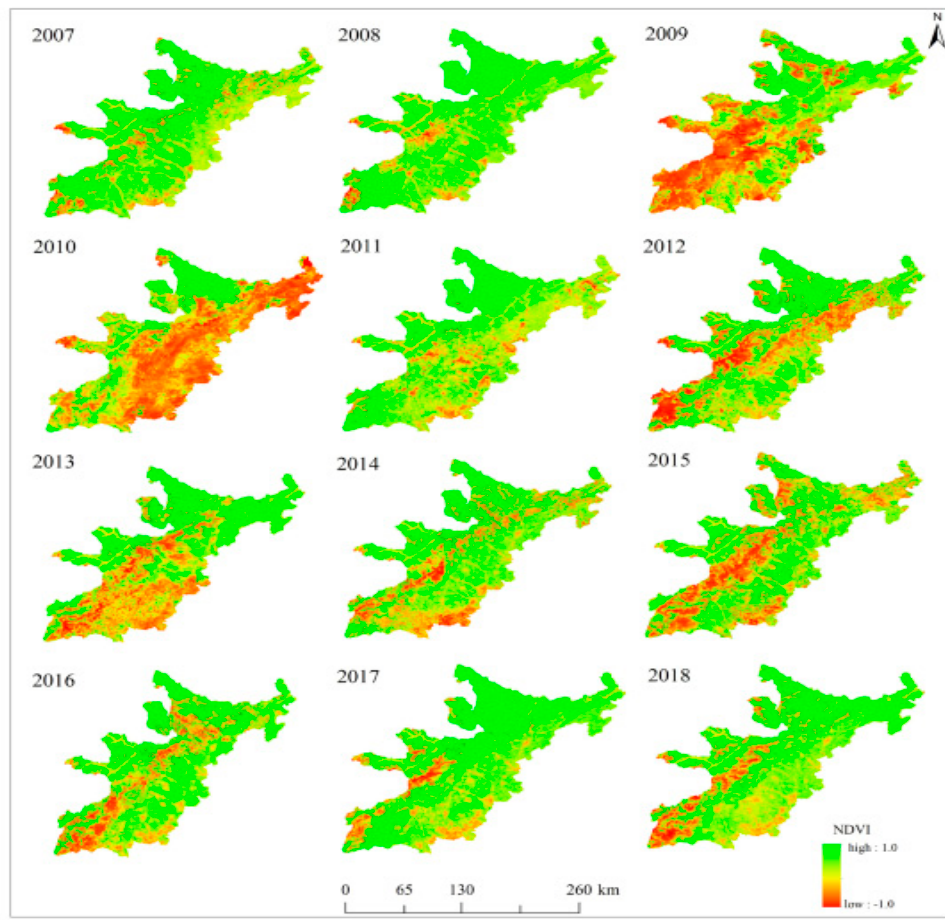
Figure 3. Changes in the annual mean MODIS-NDVI values from 2007 to 2018 in the Wenchuan epicenter.